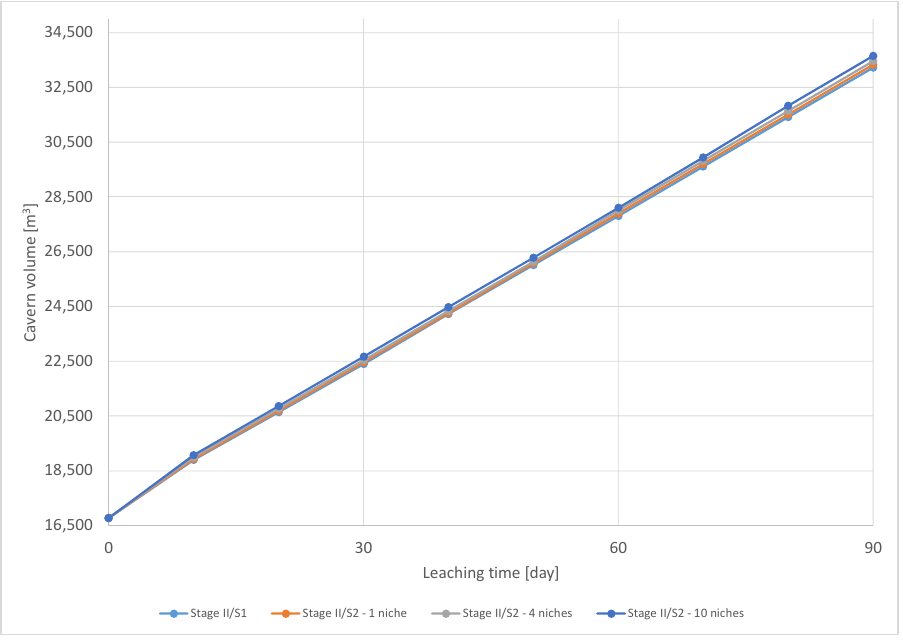
Figure 17. Comparison of the change in cavern volume for Phase I of Stage II for different scenarios.